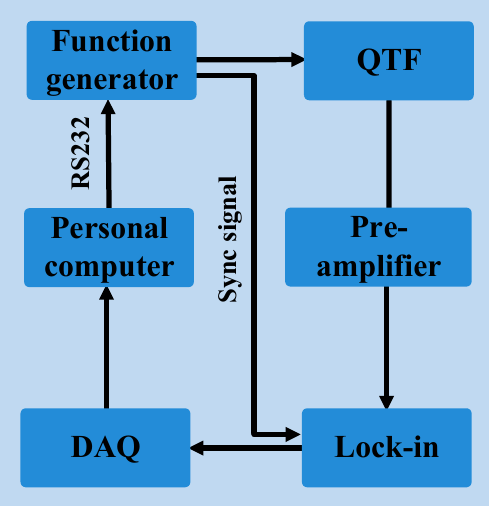
Figure 2. Circuit diagram employed for QTF characterization. QTF: quartz tuning fork, Lock-in: lock-in